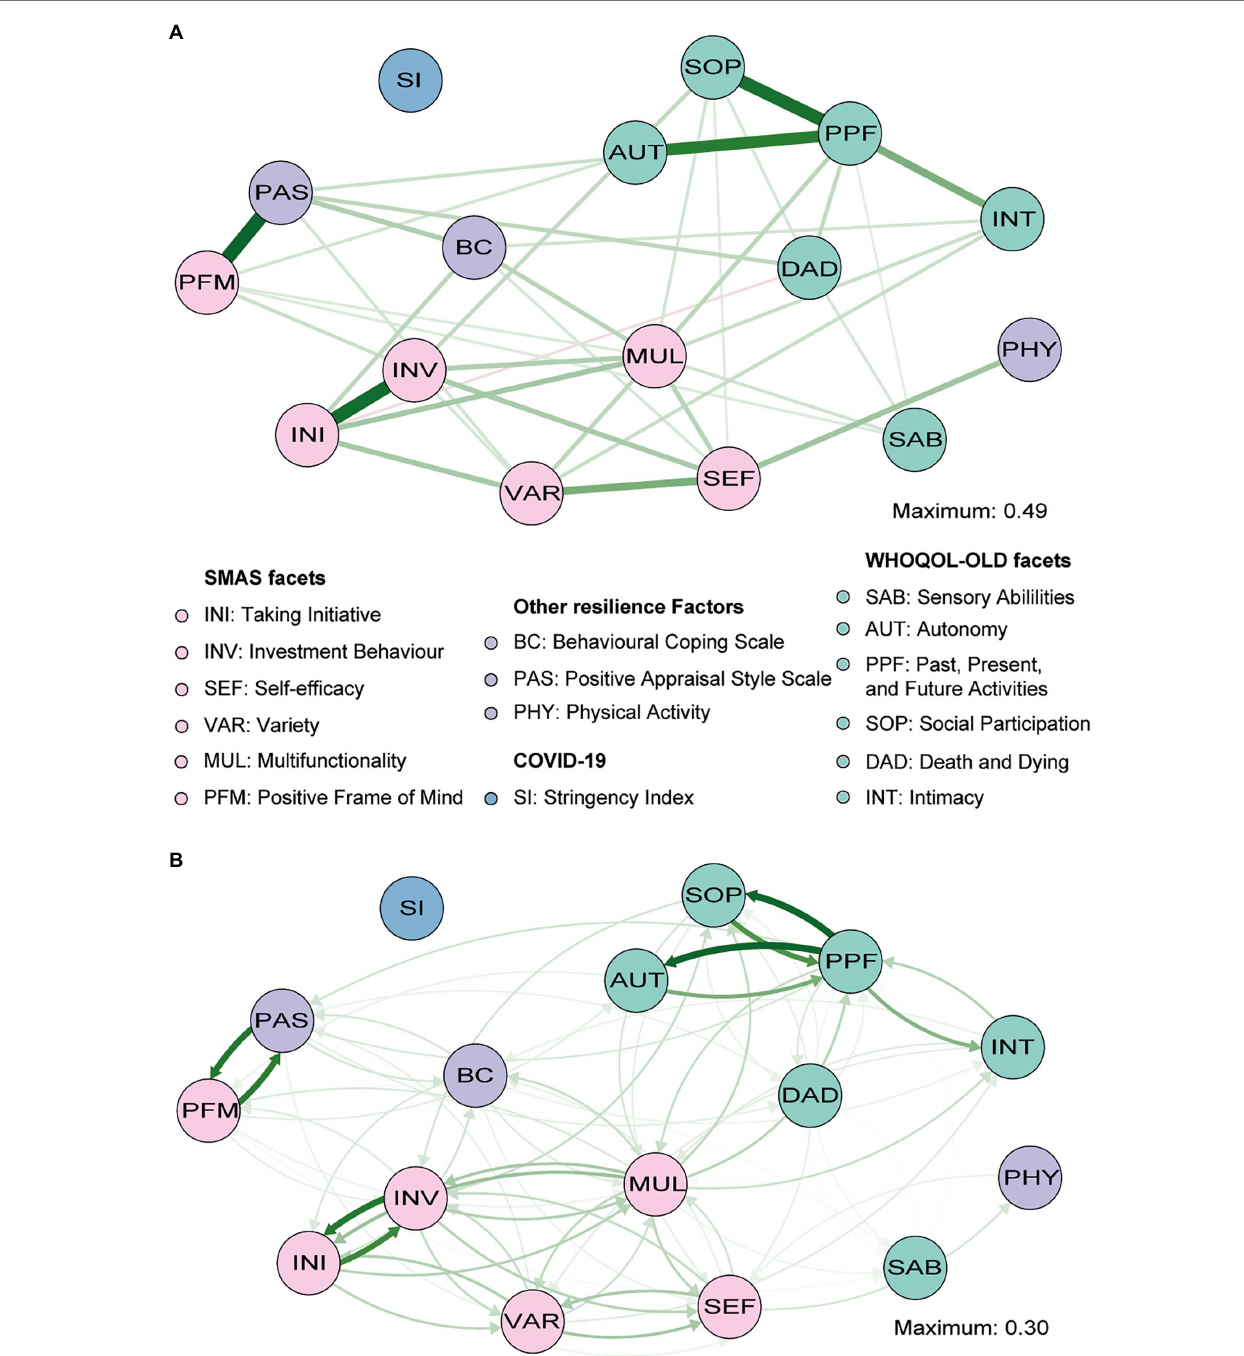
FIGURE 5 | Gaussian graphical model (GGM; A ) and directed relative importance network (B) of individual facets of QoL (green), the facets of the SMAS (pink) and other resilience factors (purple), and the stringency index (blue). The maximum value represents the highest edge weights included in the